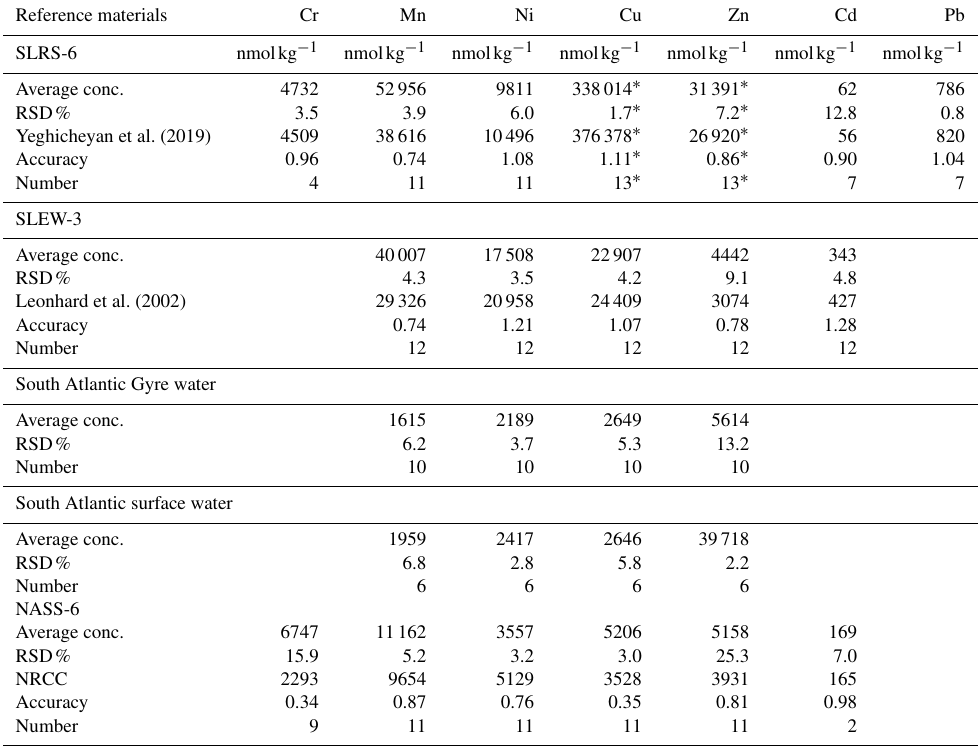
Table A2. Average concentration; RSD (1 σ in %); literature values; accuracy in comparison to literature values; and number of measurements of the reference materials SLRS-6, SLEW-3, in-house reference materials (South Atlantic surface water and South Atlantic Gyre water) and NASS-6 measured with ICP-MS. Average concentration, RSD and accuracy values displayed here are averaged from single measuring days. Cr values are analysed after dilution of the samples, and all other elements are from analyses after pre-concentration with a seaFAST